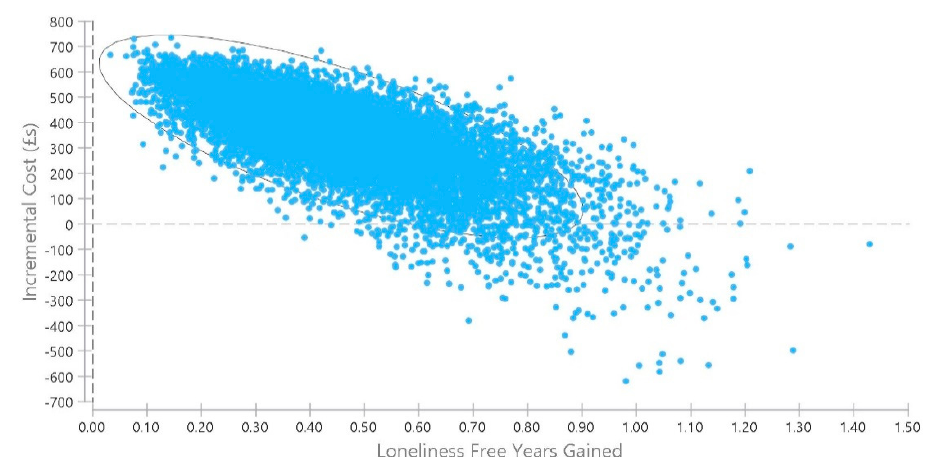
Figure 4. Probabilistic sensitivity analysis, loneliness alleviation versus no action.